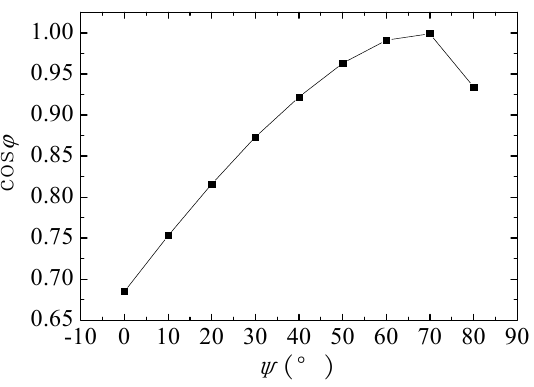
Figure 9. Power factor versus ψ